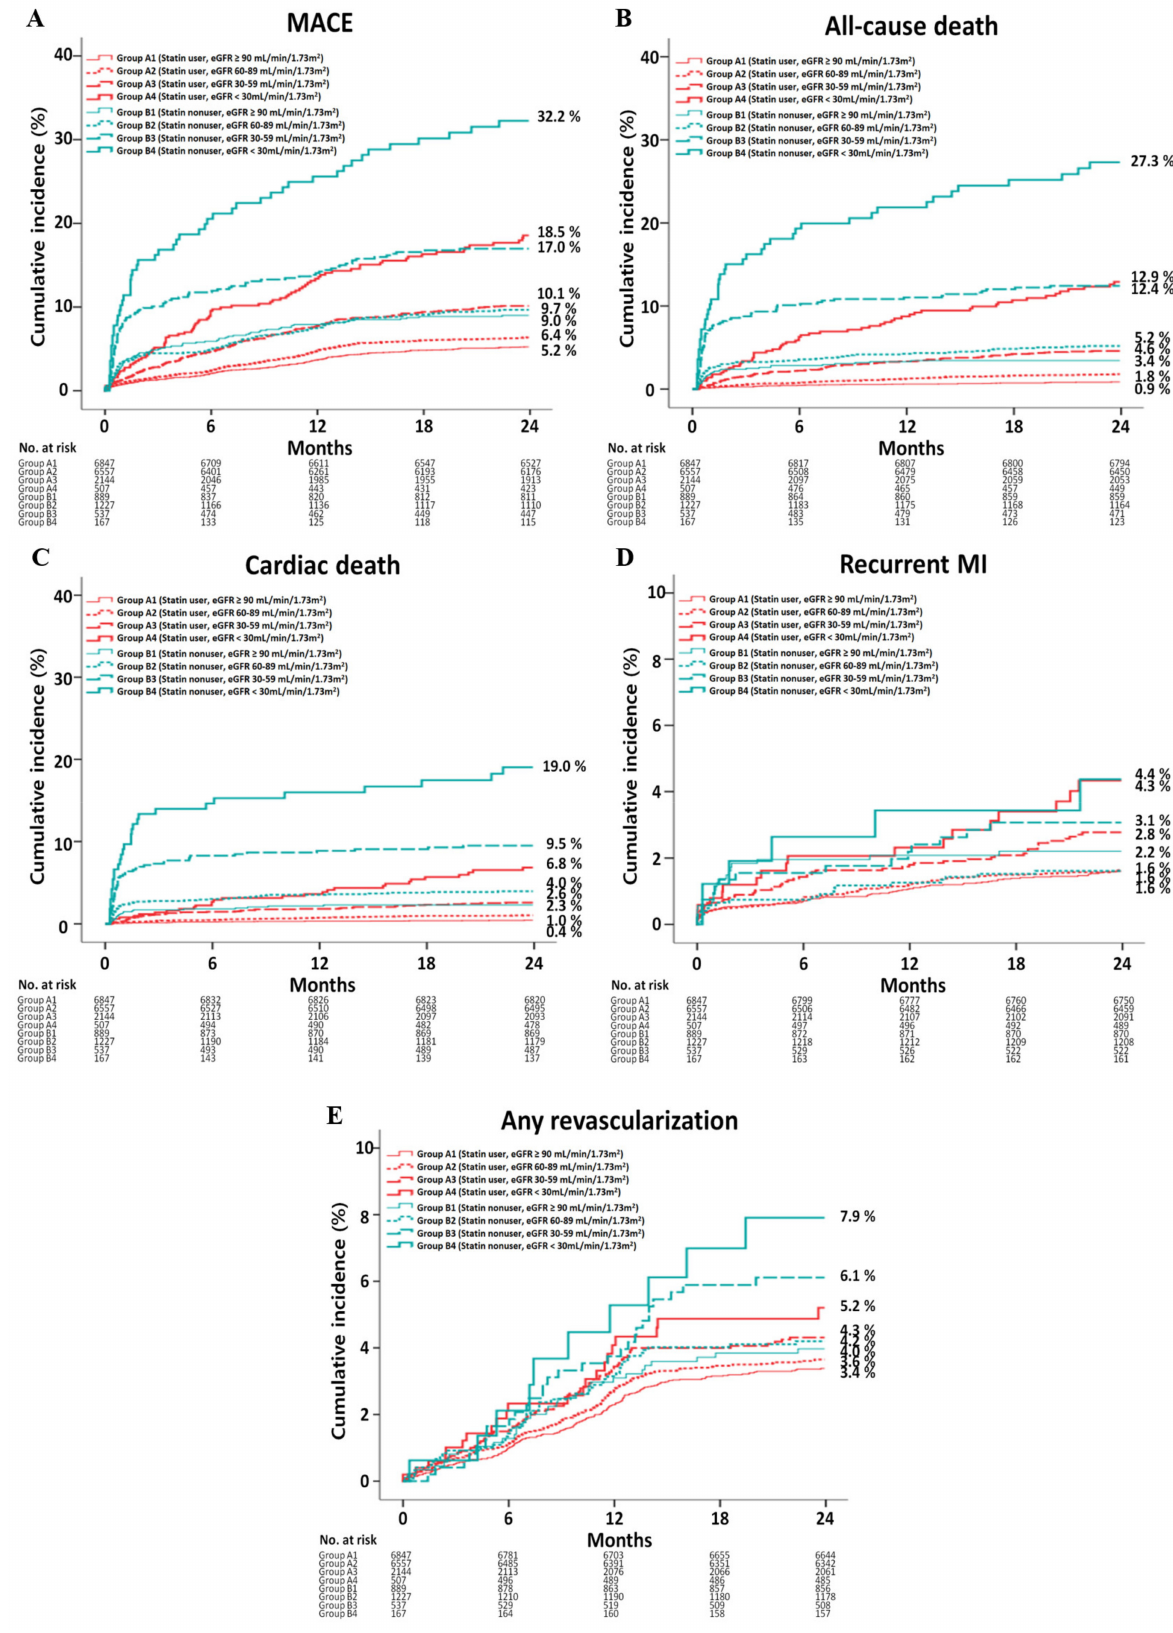
Figure 2. Kaplan–Meier analysis for the MACE ( A ), all-cause death ( B ), cardiac death ( C ), recurrent MI ( D ) and any repeat revascularization ( E ) during a 2-year follow-up